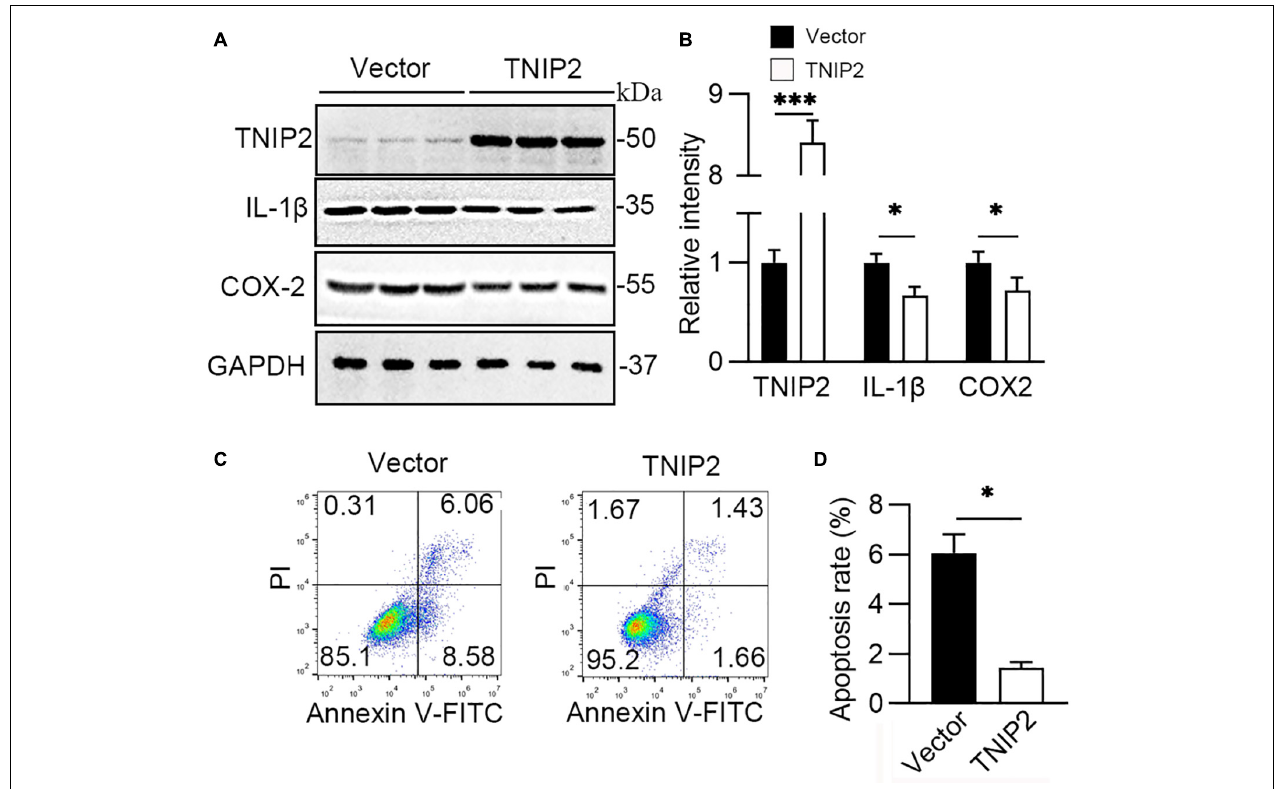
FIGURE 6 | TNIP2 blocks inflammatory pathway and inhibits cell apoptosis induced by hyperoxia. (A,B) WT (Vector) and TNIP2 overexpression A549 cells were treated by hyperoxia for 48 h, then analyzed by Western blotting with TNIP2, IL-1 β , and COX-2 antibodies and (B) their statistical results. (C,D) WT and TNIP2 overexpression A549 cells were treated by hyperoxia for 48 h and then analyzed its apoptotic rate using flowcytometry and (D) statistical result. Unpaired t -test, ∗ p < 0.05, ∗∗∗ p < 0.001 vs. Vector, n =